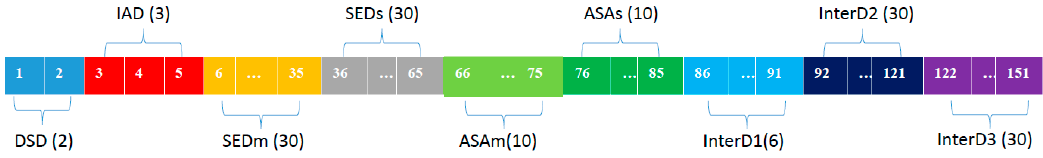
Figure 5. Illustration of structure descriptors. For each residue, a 151-bits structure descriptors were generated to characterize the structural features of target residues and their neighboring environment. DSD represents disulfide bond-based spatial location descriptors; IAD represents individual AAindex descriptors; SEDm represents spatial environment descriptor-max; SEDs represents spatial environment descriptor-sum; ASAm represents ASA value-max; ASAs represents ASA value-sum; InterD1 represents integration of disulfide bond-based spatial location descriptors and individual AAindex descriptors; InterD2 represents integration of ASA value and AAindex-max; InterD3 represents integration of ASA value and AAindex-sum.